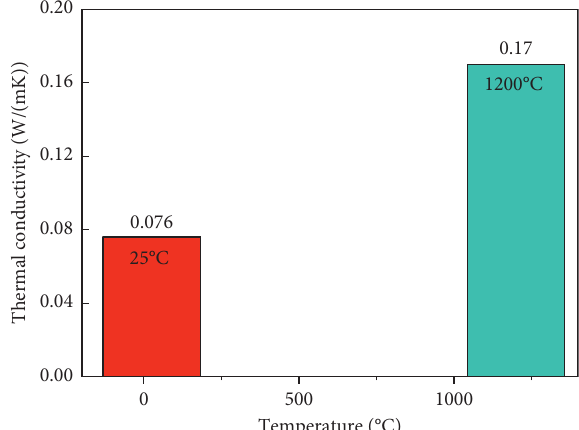
Figure 7: Thermal conductivity diagram of the carbon/carbon fiber